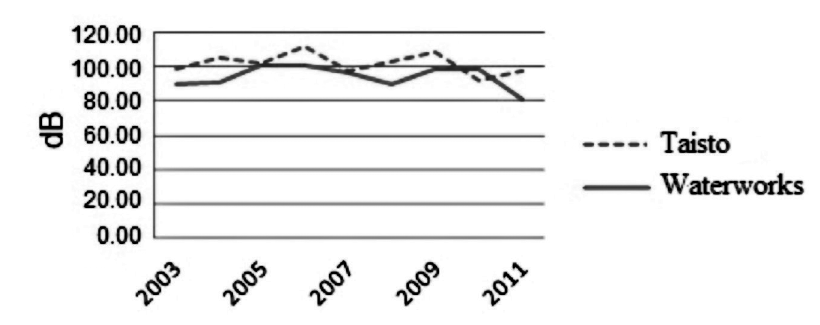
Fig. 2. The highest noise levels in noise monitoring terminals in 2003–2011 (Keskküla 2012b)